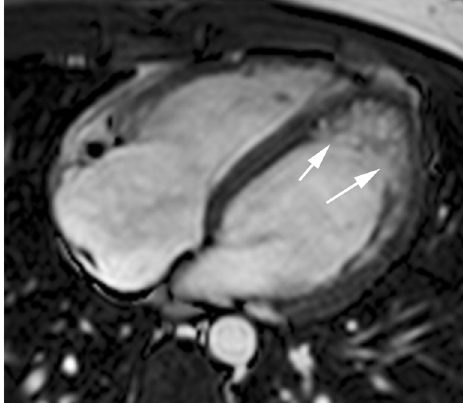
Fig. 3 22-year-old man with a family history ofHCM, genotype positive, phenotype negative. End-diastolic SSFP cine MR images showing prom- inent trabeculations in the LVapex (arrows) and normal miocardial thick- ness. These MRI features are indistinguishable from LV